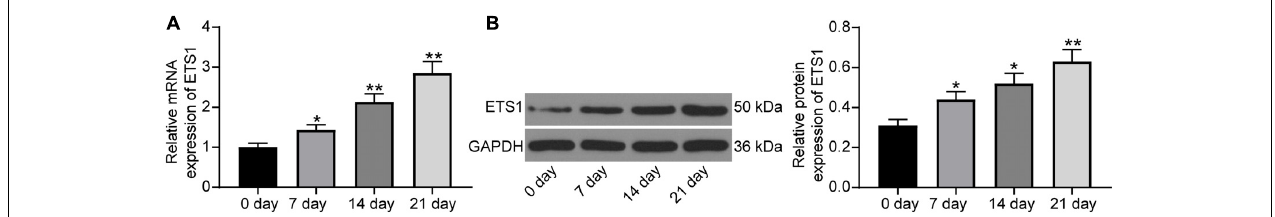
FIGURE 1 | ETS1 is upregulated during osteogenic differentiation. (A,B) mRNA (A) and protein (B) expression of ETS1 in MC3T3-E1 cells during osteogenic differentiation measured by RT-qPCR and western blot analysis, respectively (one-way ANOVA, * p < 0.05; ** p < 0.01, compared to day 0).